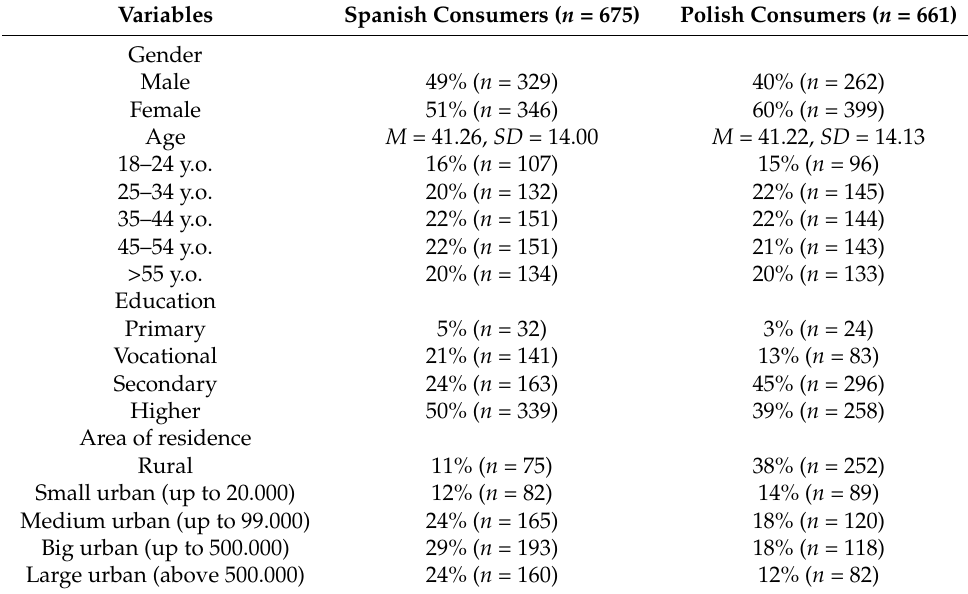
Table 1. Respondents’ profile in the Spanish and Polish